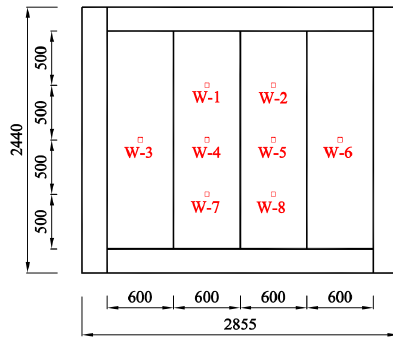
Figure 6. Position of the LVDT.